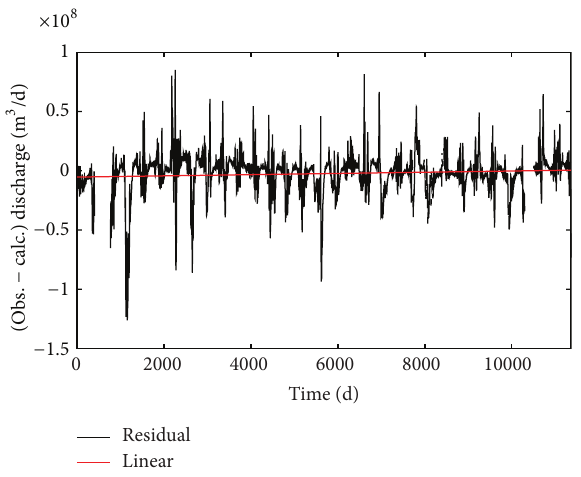
Figure 6: Model residual and difference between observed dis- charge and calculated discharge. Data period from 1978 to 2006.